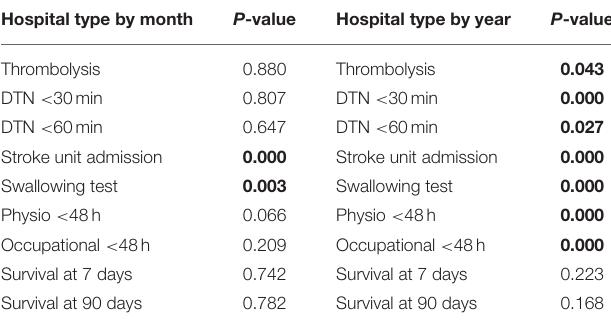
TABLE 2 | Significance test for interaction terms between hospital type by month of admission, and hospital type by year of